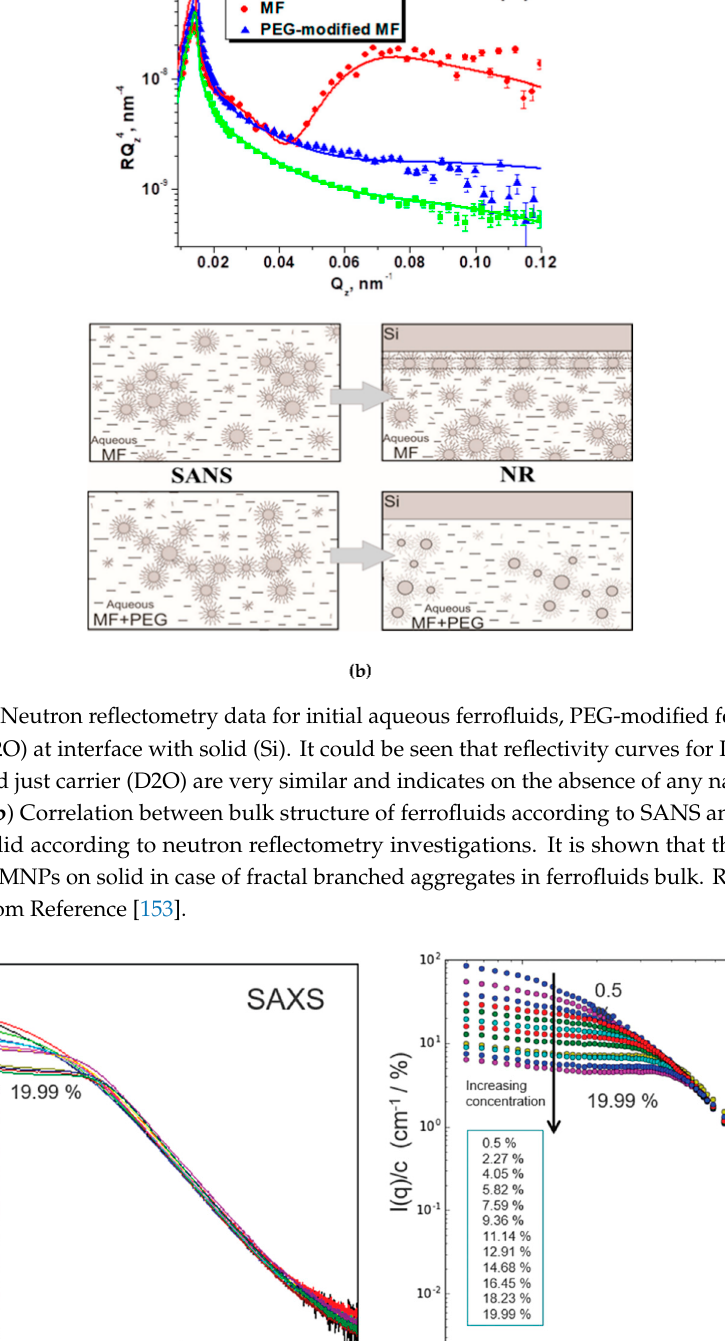
Figure 17. SANS data for the Fe 3 O 4 /OA aqueous MF at different concentrations (left). Plot of the ‘‘apparent’’ structure factor (right). The SANS data have been divided by the data for a low- concentration sample (1%), without any further scaling. Reproduced from Reference [85] with permission from The Royal Society of Chemistry. 4.4.2. Light Scattering Light scattering based structural characterization of magnetic colloids are an affordable laboratory table top alternative to SANS and SAXS. Therefore, a wide spectrum of equipment is already available on the market to help researchers with the fast and accurate characterization of magnetic colloids at nano and mesoscale, both spontaneous and magnetically induced. Dynamic Light Scattering (DLS) uses the photon correlation spectroscopy to determine the colloidal particle hydrodynamic diameter from the time fluctuations of the light scattered by the colloid sample [157]. Static Light Scattering (SLS) uses the angle dependence of the scattered light intensity to determine the colloidal particle diameter via the Lorentz–Mie light scattering theory